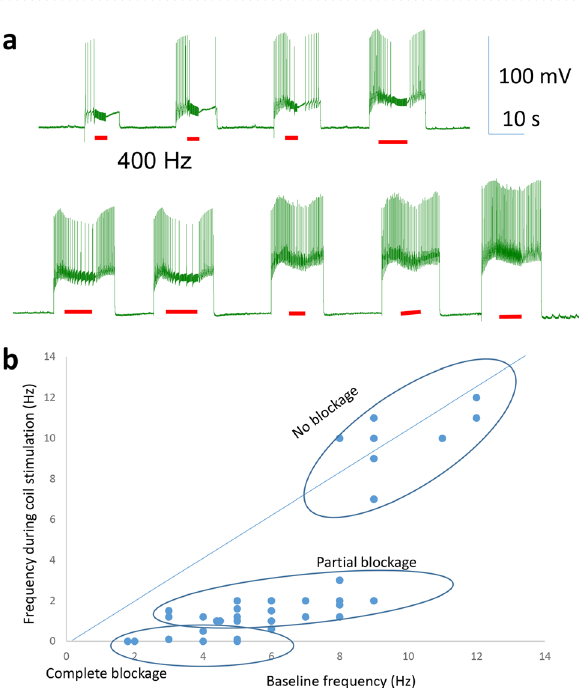
Figure 5. State-dependent soma inhibition by the miniature coil with a range of stimulation frequencies. Neural activity in a spontaneously firing neuron was recorded. Stimuli (red bars) ranging in frequency (5–1000 Hz) were applied to the coil. ( a ) Magnetic stimulation had a minimal effect when the neuron was at a high firing state (> 3 Hz). ( b ) Complete magnetic inhibition was observed for all stimulation frequencies when the neuron was at a low firing state (< 1.5 Hz).